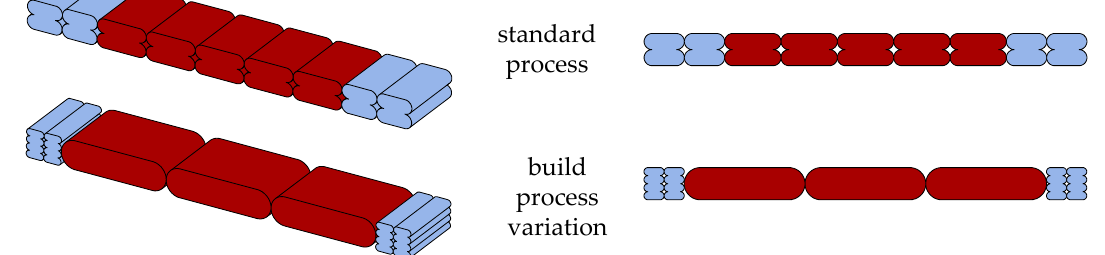
Figure 14. Layer configuration in standard fused filament fabrication and the process variation approach (based on the work in [77]).